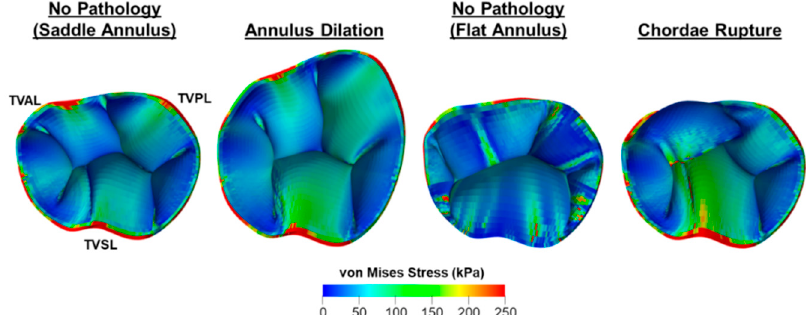
Figure 17. Representative FE results adopted from an ongoing study by Laurence et al . (2019) [187].